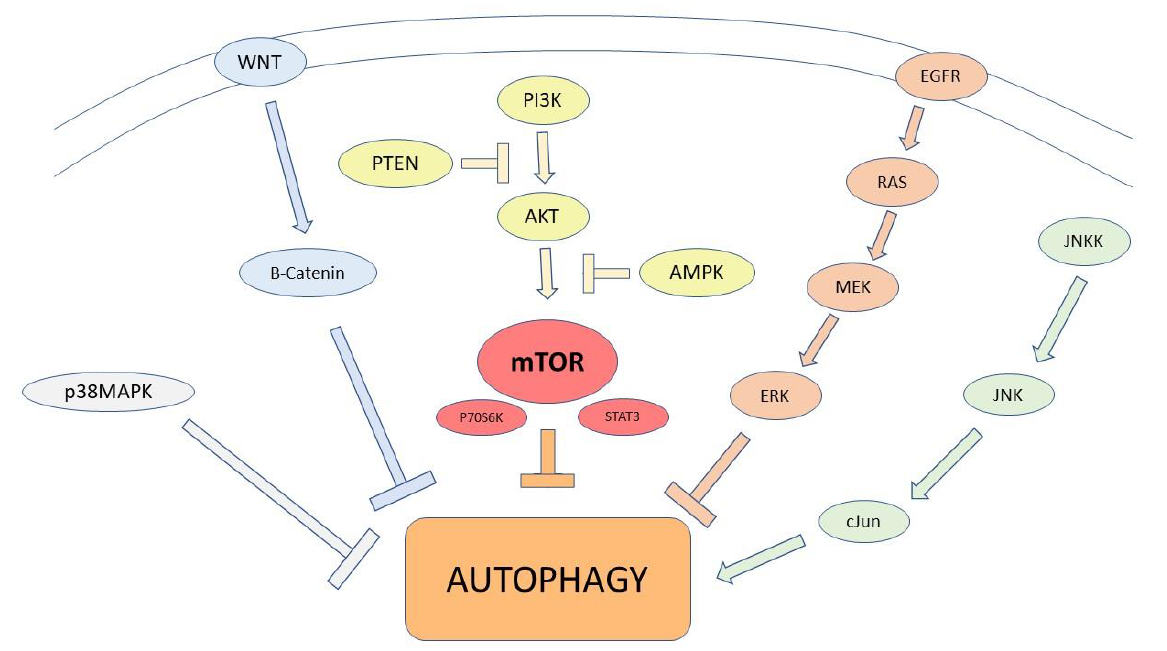
Figure 3. Main pathways involved in autophagy regulation. PTEN and AMPK downregulate the PI3K/AKT/mTOR signaling pathway, to enhance autophagy. mTOR suppresses autophagy acting via P70S6K and STAT 3 expression. The activation of the EGFR/Ras/MEK/ERK pathway, JNK/cJun, and p38MAPK signaling pathways promotes autophagy. The Wnt/β-catenin signaling pathway attenuates Beclin1-mediated autophagy.